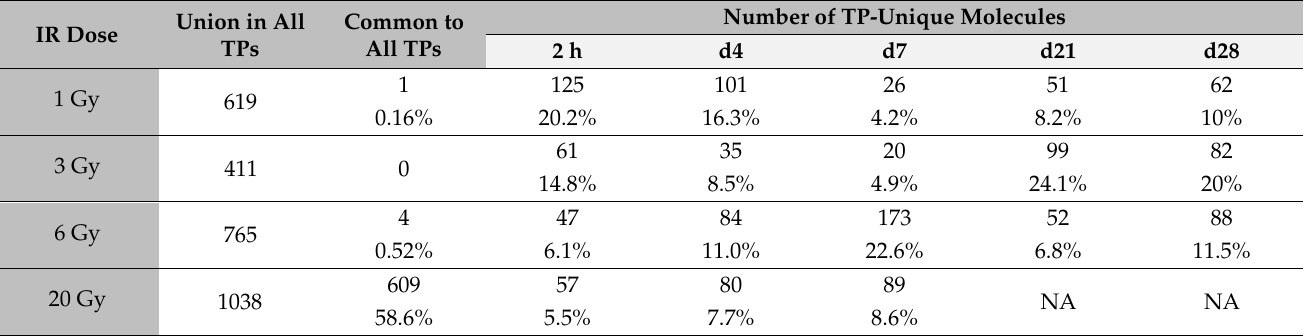
Table 2. Distribution of SDTGs on time points using independent analysis for each IR